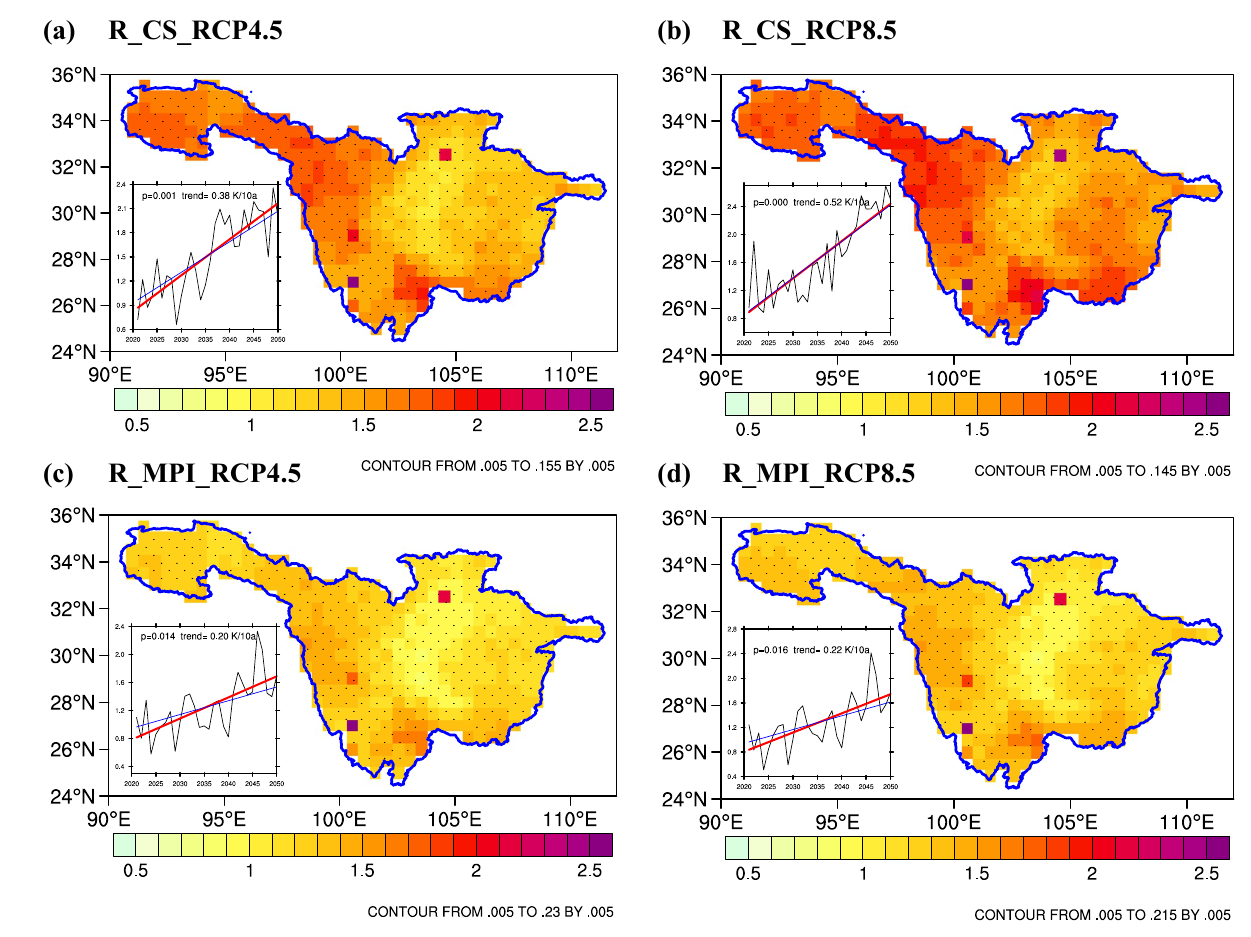
Figure 9. Multiyear average changes (unit: ℃ ) in T 2m over the UYRB under the RCP4.5 and RCP8.5 scenarios compared to the reference period (1971–2000). The black dots denote differences that are statistically significant at a significance level of 95% based on Student’s t-test. The rectangle indicates the interannual variation trend of air temperature anomalies (unit: ℃ /10 a). The figure was prepared using The NCAR Command Language version 6.5.0. (https:// doi. org/ 10. 5065/ D6WD3 XH5). R_CS R_MPI Periods